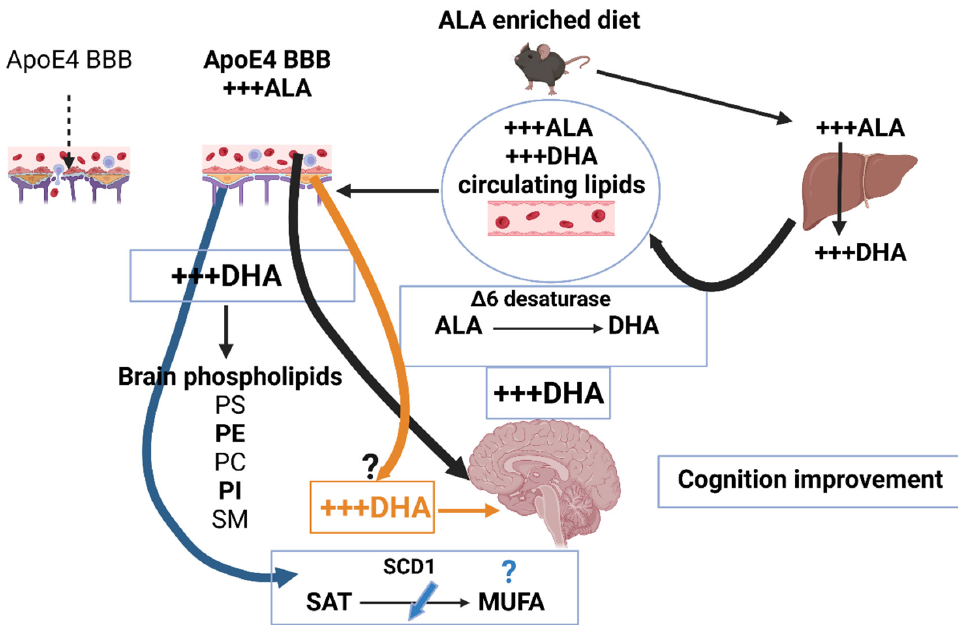
Figure 1. Conceptual model. This schematic picture illustrates how dietary fatty acids are ingested by the offspring, from the mother through the placenta, or by adult mice directly from the diet. Ingested FA are modified through the hepatic metabolism. High ALA levels increase DHA produc- tion through the pathway regulated by the key enzymatic ∆ 6 desaturase (black arrow on the right). Circulating FA reach the BBB. The decreased n-3 FA brain accretion, through Mfsd2a transporter expressed on brain endothelial cells, and dysfunctional BBB (left BBB cartoon) in AD are restored by ALA dietary enrichment (right BBB cartoon). Thus, increased DHA production rescues BBB func- tion, brain accretion and phospholipids composition (left black arrow). These ALA induced modi- fications positively impact cognitive functioning. The potential desaturation of ALA to DHA by BBB may also contribute to brain DHA (orange arrow). The high SCD1 activity in AD on the transfor- mation of Saturated to MUFA may be inhibited by ALA (blue arrow). Figures in this manuscript were created with Biorender. with